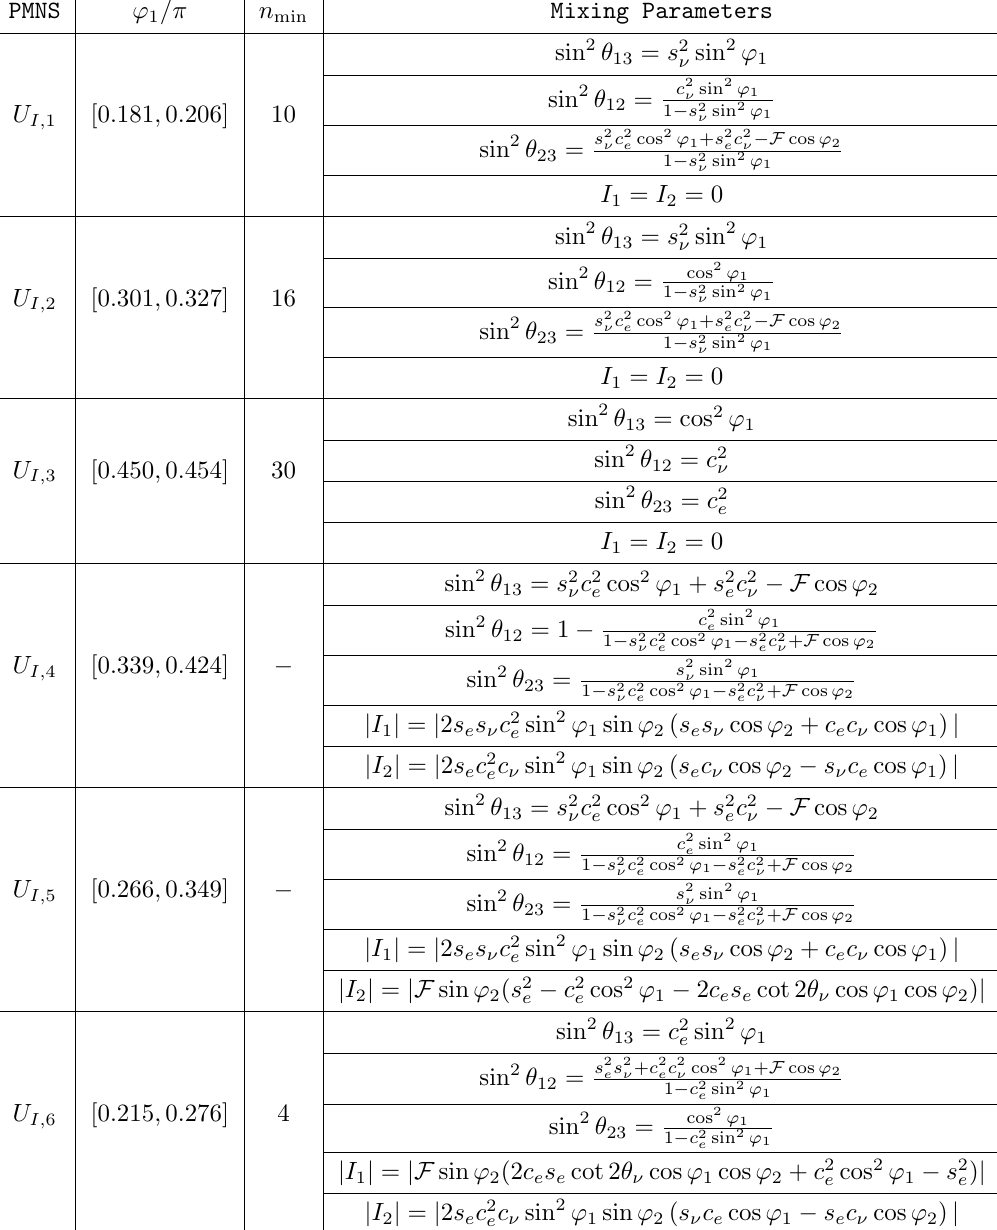
Table 2 . The predictions of the lepton mixing parameters for the mixing patterns in eq. (4.8). The absolute value of the Jarlskog invariant J CP [59] is the same for all the nine mixing patterns, i.e. j J CP j = 1 j sin 2 (cid:18) e sin 2 (cid:18) (cid:23) sin 2 ’ 1 cos ’ 1 sin ’ 2 j . The symbols I 1 and I 2 are Majorana CP 2